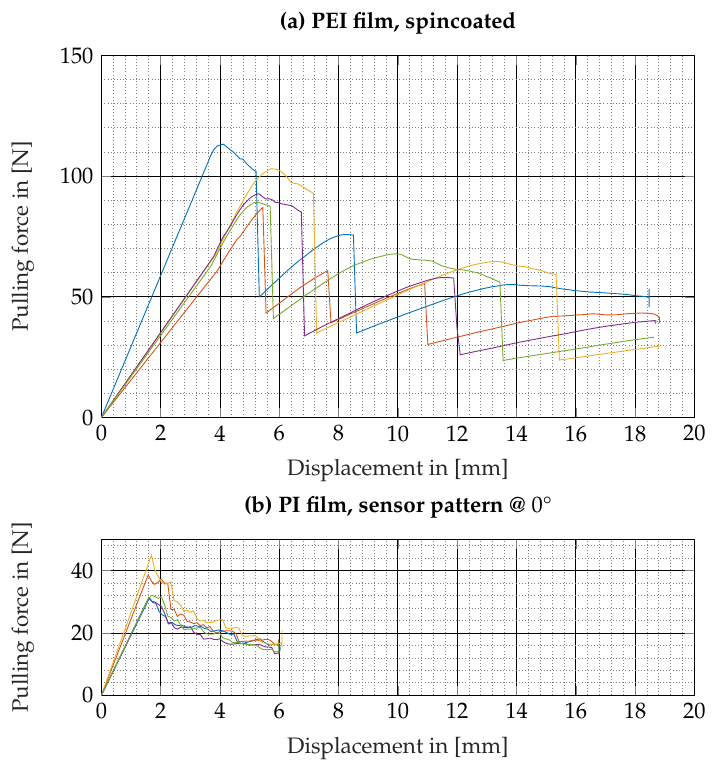
Figure 9. Force displacement curves for DCB specimens with spin-coated integrated films: ( a ) Pronounced crack jumping visible as force breakdowns in the specimens with integrated spin- coated PEI film. That behaviour is visible in all specimens with spin-coated PEI film with and without sensor patterns. ( b ) No crack jumping in specimens with PI film and applied sensor pattern @ 0°.